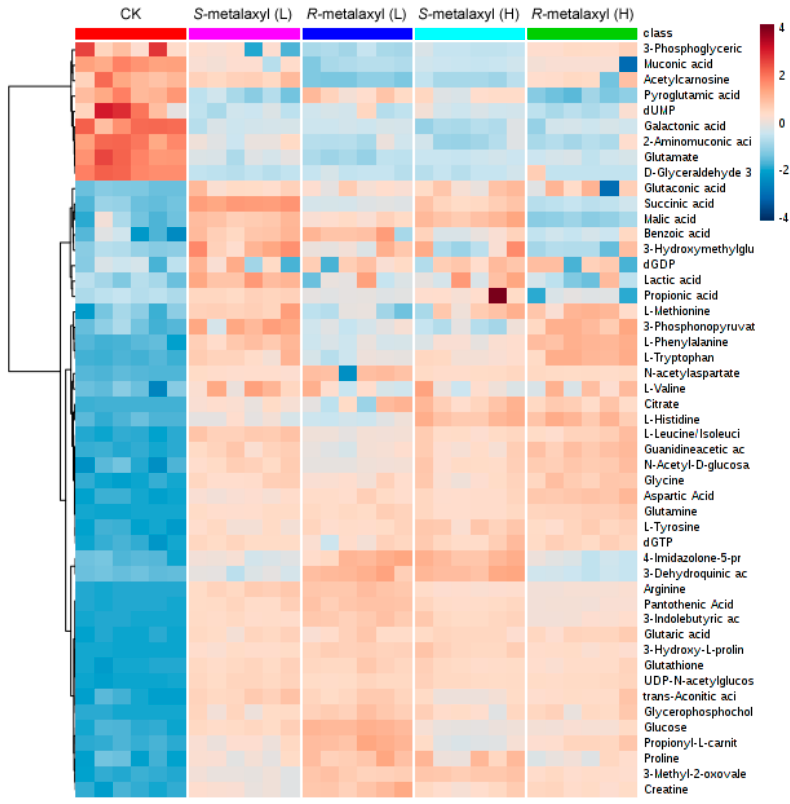
Figure 4. Heat map produced by the most significantly differential metabolites.